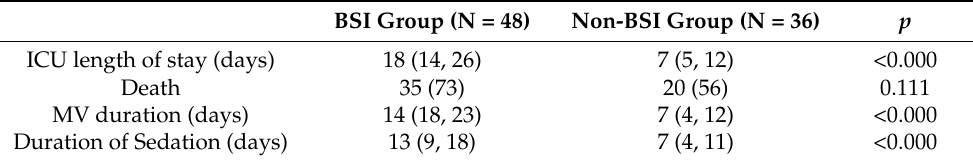
Table 5. Outcomes.